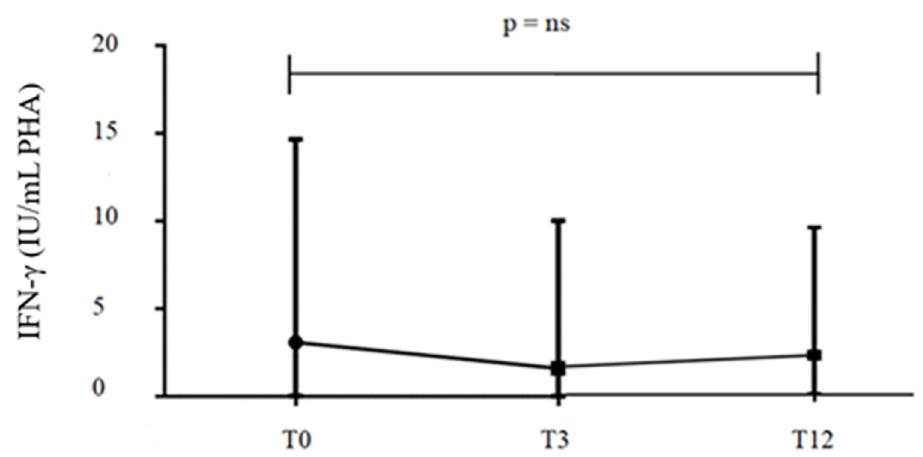
Fig 3. Comparison between the median values of INF- γ in response to the PHA mitogen of QFT-P before and after 3 and 12 months of therapy with Jaki. PHA: phytohemagglutinin; QFT-P: QuantiFERON-TB Gold Plus; Jaki: Janus kinase